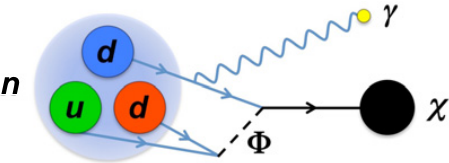
Figure 2. Neutron dark decay n → χ φ in Model